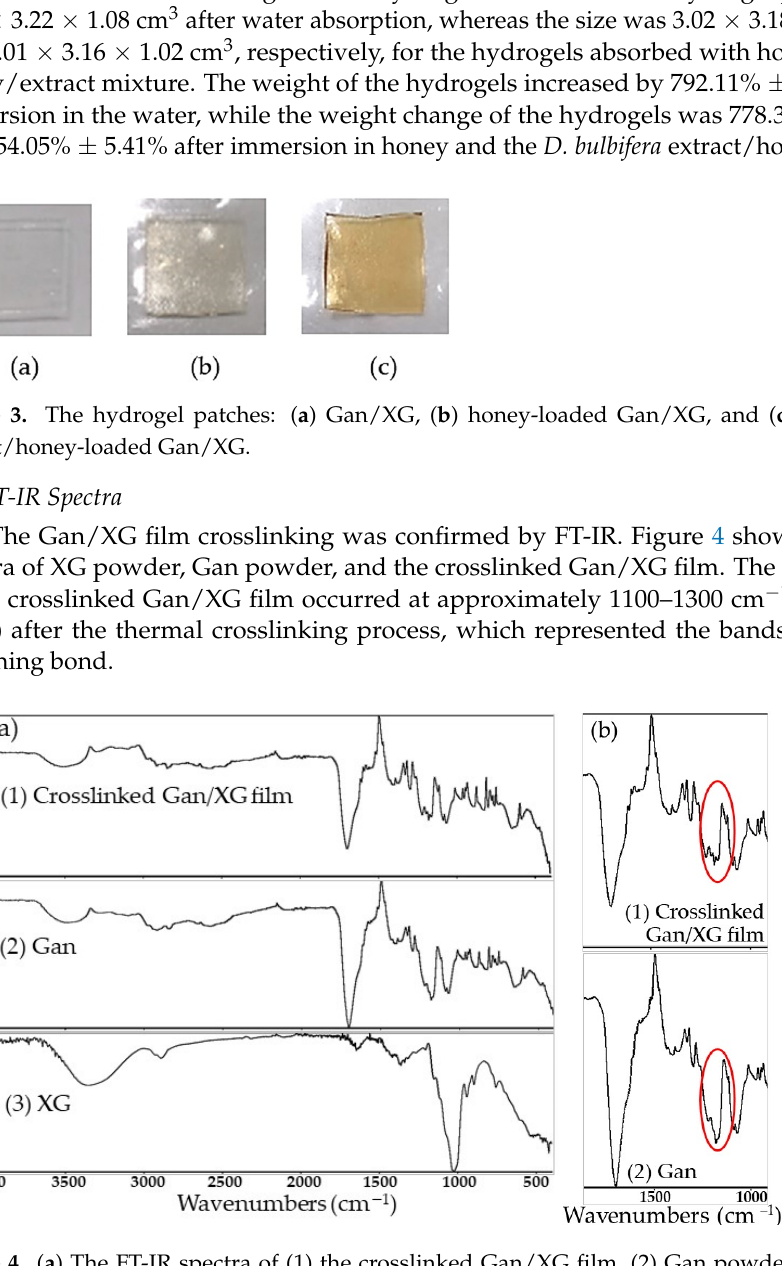
Figure 4. ( a ) The FT-IR spectra of (1) the crosslinked Gan/XG film, (2) Gan powder, and (3) XG powder. ( b ) Expanded FT-IR spectra of (1) the crosslinked Gan/XG film and (2) Gan powder. Red circles show the new spectra of the crosslinked Gan/XG film compared with Gan